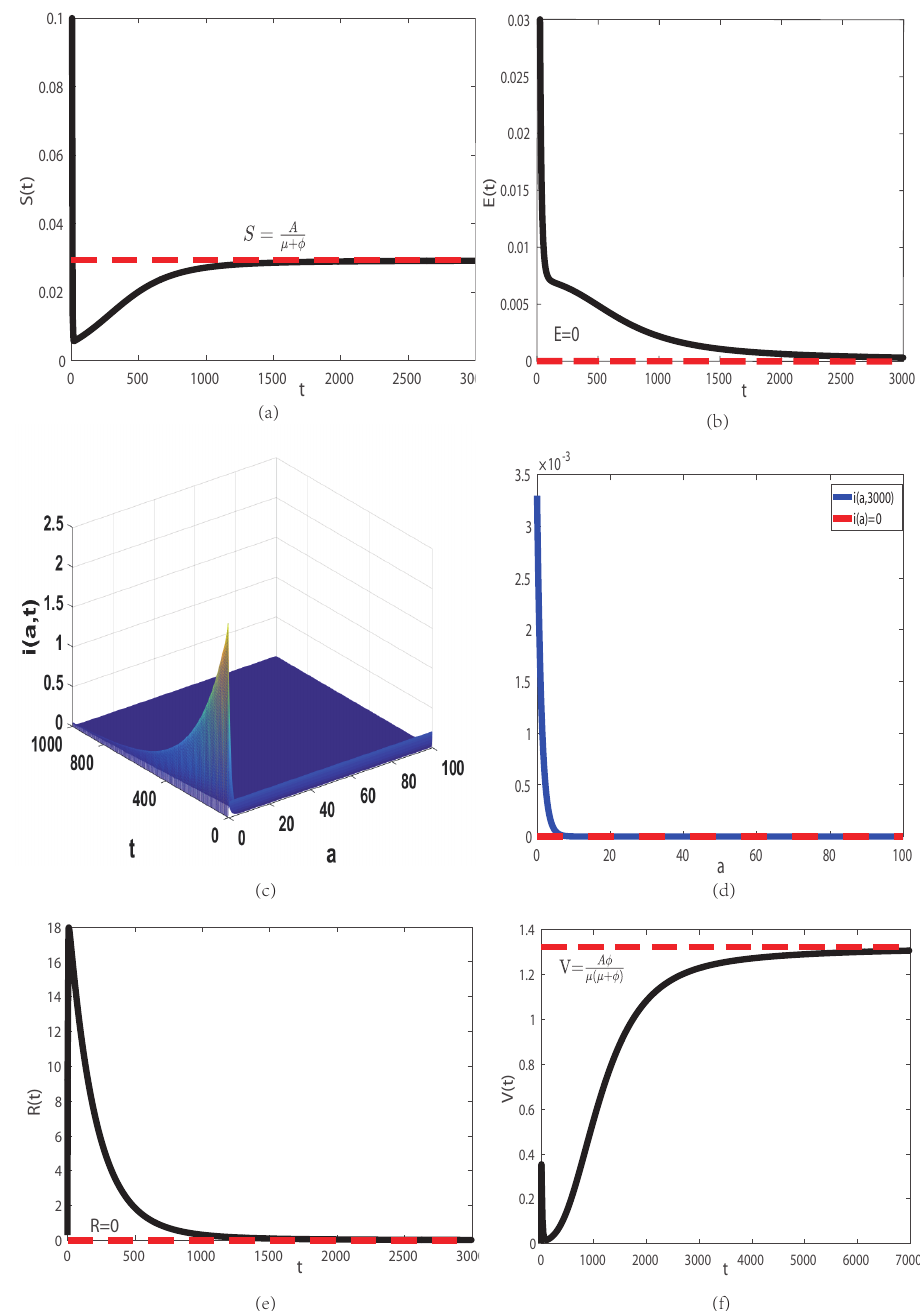
Figure 2. The red dashed lines display the estimate of the disease-free equilibrium E 1 ( A , A φ , 0, 0, 0 ) of model (3a–e)–(5), while other color lines lines show solutions with µ + φ µ ( µ + φ ) A = 0.003, φ = 0.1 from the direct simulation. The initial conditions and other parameters are the same as those in Figure 1. Similar to Figure 1, ( a ) S ( t ) , ( b ) E ( t ) , ( e ) R ( t ) and ( f ) V ( t ) with respect to t are shown. ( c ) i ( a , t ) with respect to a and t is displayed. ( d ) i ( a , t ) with respect to a at t = 3000 is